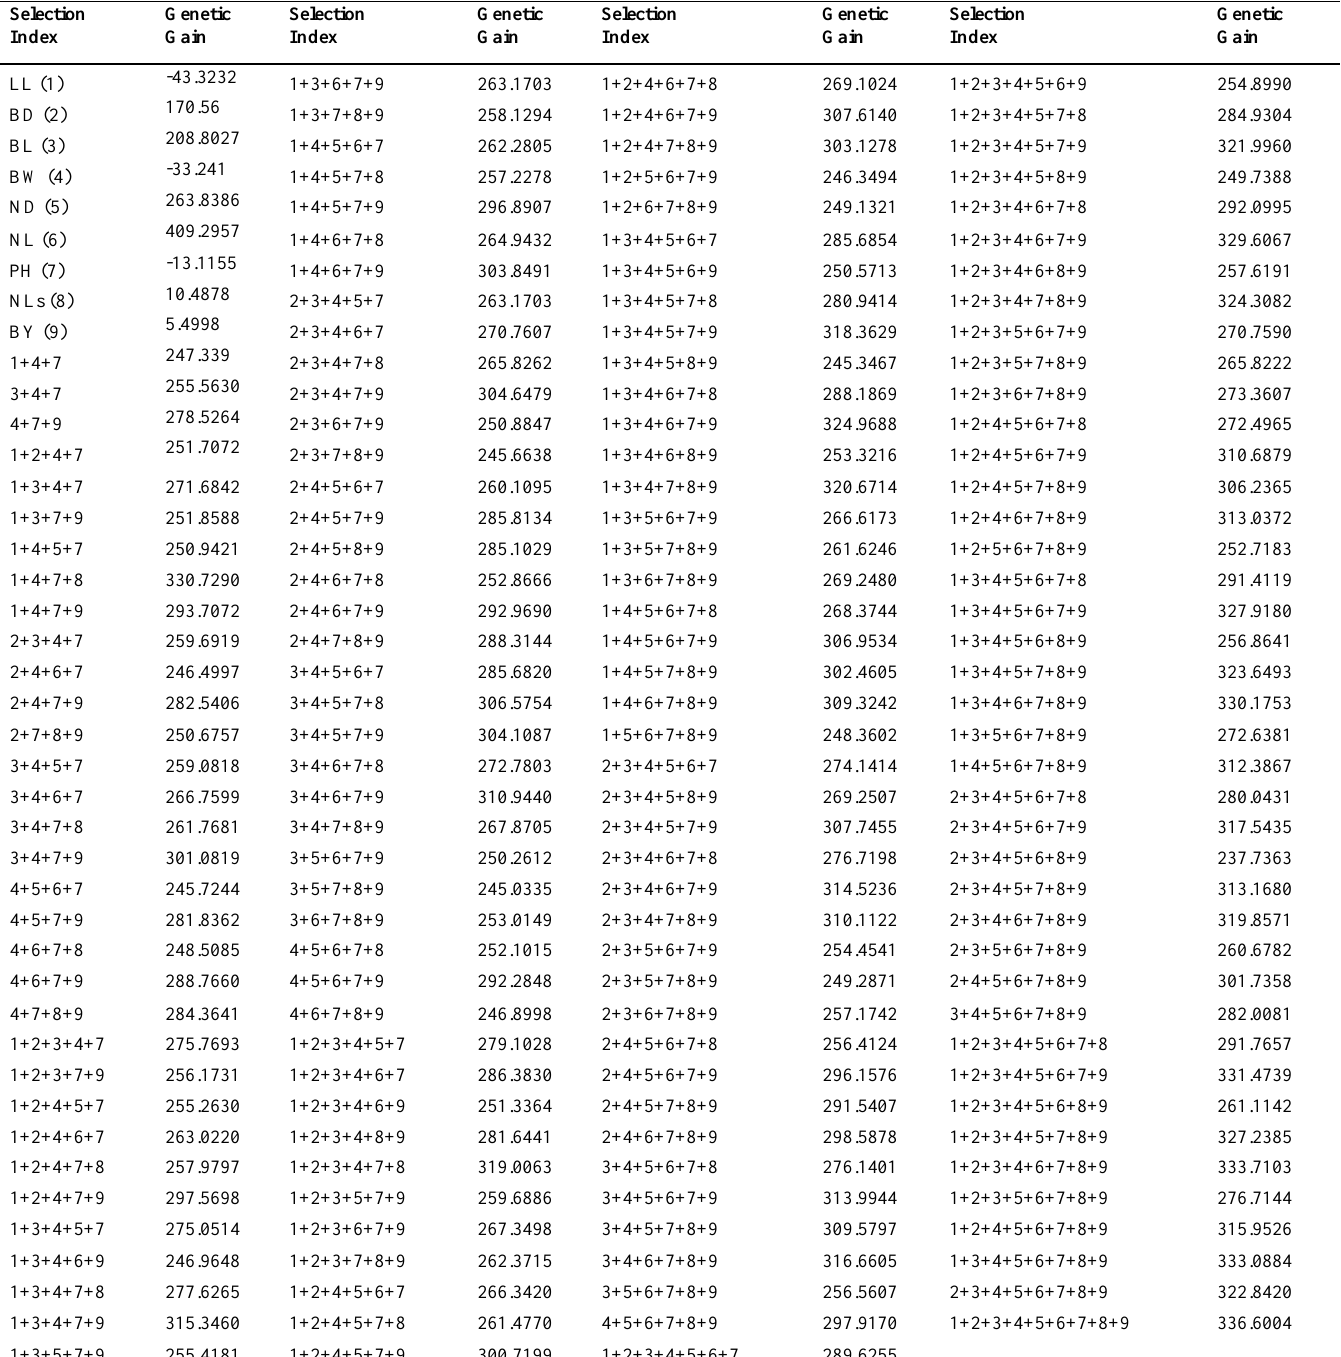
Table 6 . Expected genetic gain in percent of bulb yield over straight selection from the use of various selection indices in onion. Index showing values over 245 are shown